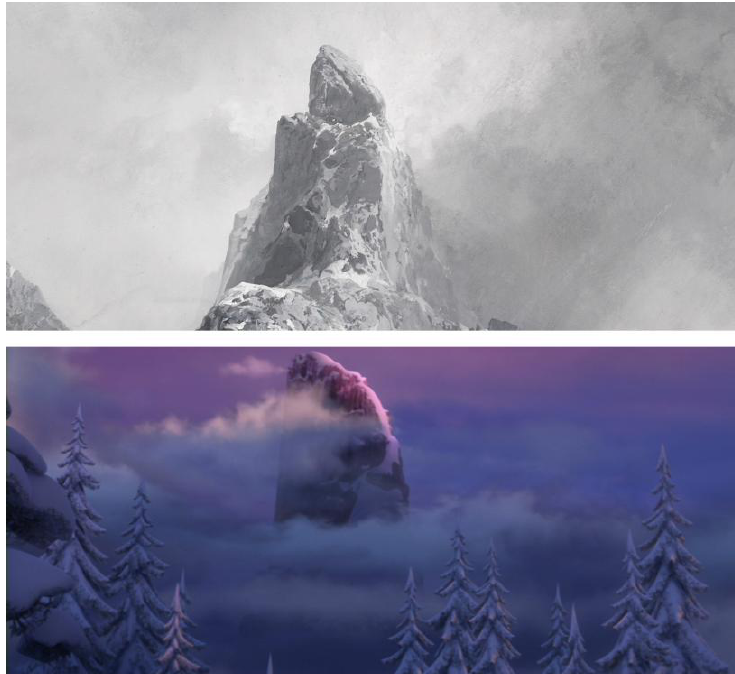
Figure 4. Graphical composition that shows the permanence of the image of alpine Sublime in a 19th century painting (Edward Theodore Compton, Der Cimon della Pala in den Dolomiten, 1896 [29], detail) and in a frame of a 21st century animation movie ( Frozen by Walt Dysney Animation Studios, 2013). It is possible to note the similarity in the shape, in the verticality of the faces, the use of clouds to strengthen the sublime emotional effect, the low point of view to strengthen the sense of overwhelming